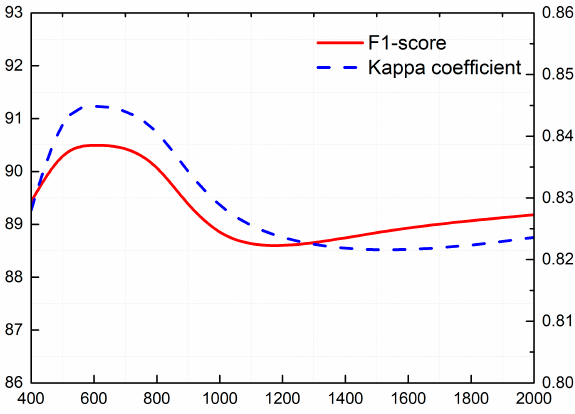
Figure 7. Effect of superpixels’ sizes for the segmentation results of AGCN on the Fangchenggang dataset.